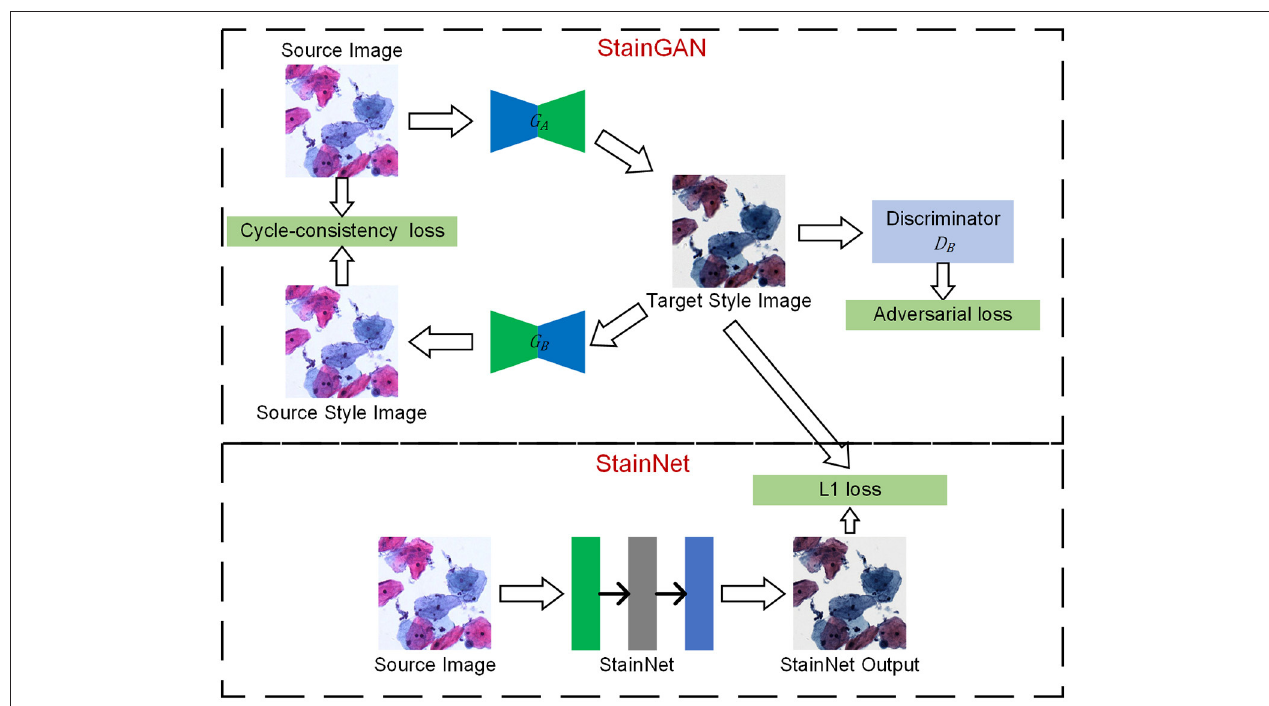
FIGURE 1 | The framework of StainNet. First, StainGAN normalizes the images from the source domain to the target domain. Then, the normalized images by StainGAN are set as Ground Truth to train StainNet. The images from the source domain are mapped to the source domain and then back to the target domain by StainGAN. The same reverse process is also performed for images from the target domain. StainNet is a fully 1 × 1 convolutional neural network, which can directly map the images from the source domain to the target domain.